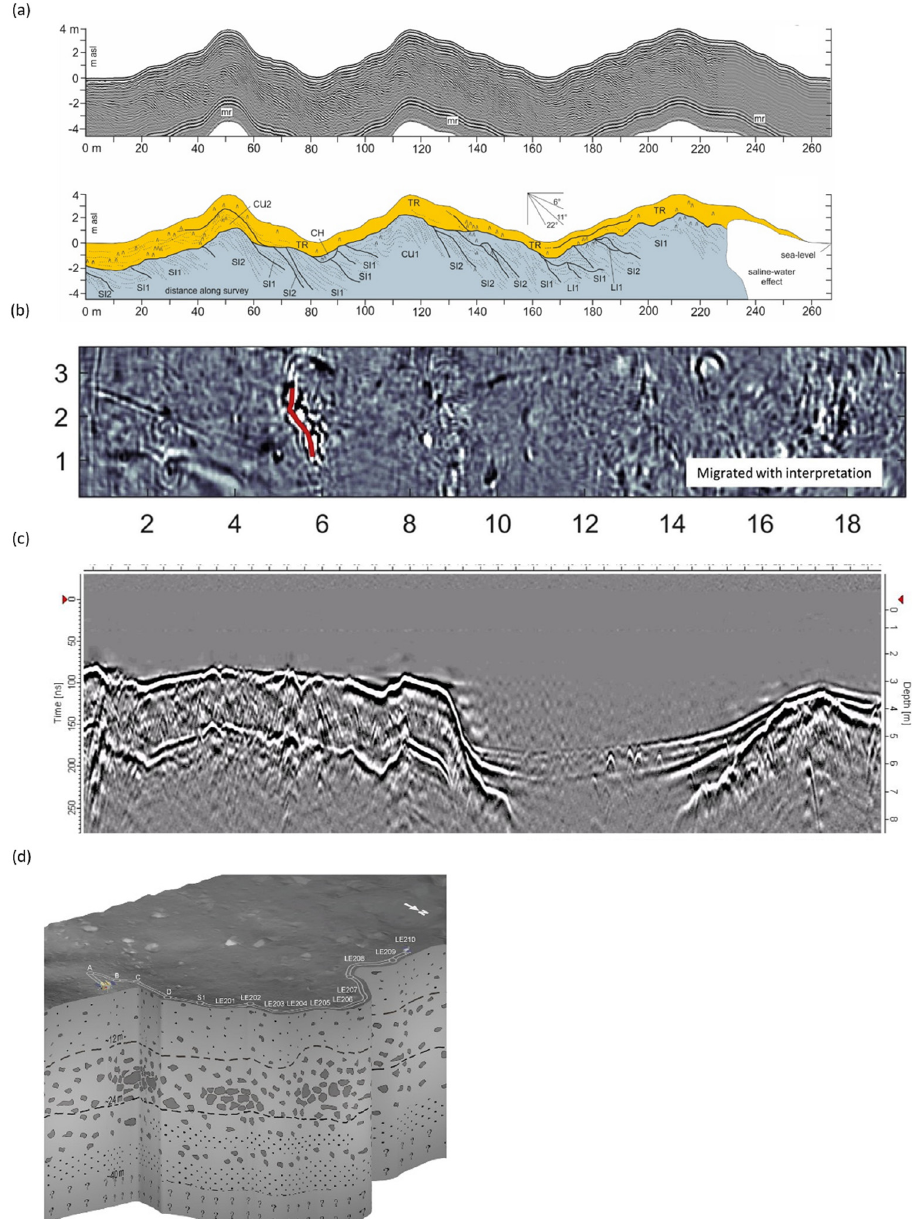
Figure 5. Examples of GPR application in geology. ( a ) A 600 MHz radargram acquired over a coastal dune characterized by erosion, accretion, and equilibrium to delineate its internal stratigraphy. Corresponding model highlighting the upper Aeolian unit (yellow) and lower marine unit (blue). ( b ) A 450 MHz GPR depth slice (1.32 m depth) over a vertical and sub-vertical fracture network showing the typical diffraction events generated by such horizons. ( c ) The 100 MHz unshielded antennas for lake-bottom profiling investigations. ( d ) Subsurface internal structure at the landing site as inferable from the Chang’E-4 500 MHz GPR survey over the far side of the moon. Adapted with permission from [245,253,286,299]. Copyright 2020/2021, Elsevier .